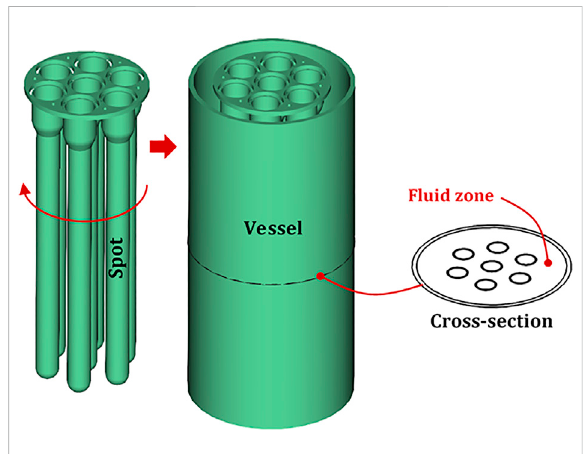
FIGURE 2 Sketchofthenovel Matrix-in-Batch rotatingreactorOnePot © considered in the present work. The actual system subject of investigation is the fl uid zone of the cross-section. The oriented red arrow near the spots indicates the sense of